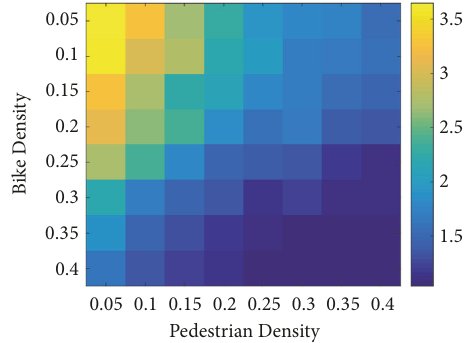
Figure 12: Average influenced bicycle speed for path with conven- tional bus